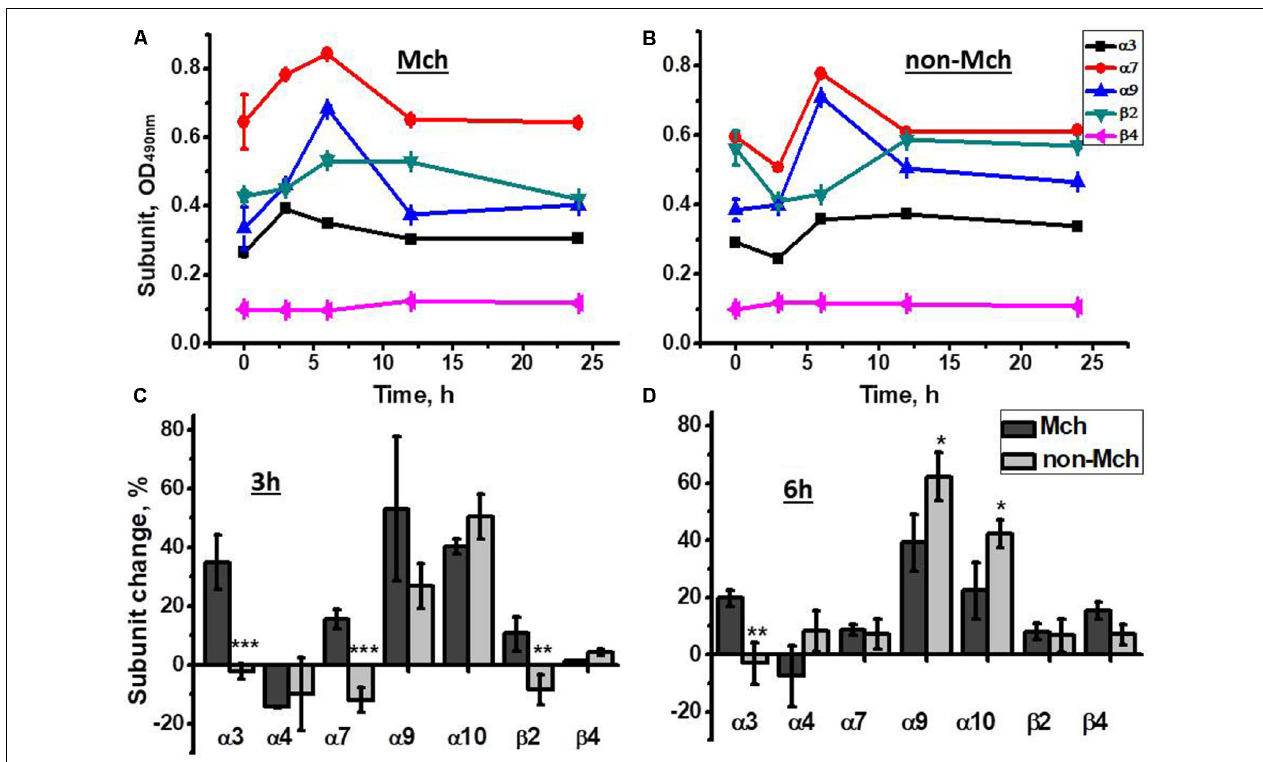
FIGURE 2 | The changes in nAChR subunits content in the mitochondria (Mch) and mitochondria-depleted (non-Mch) liver fractions of rats subjected to PHE. (A,B) Absolute OD values, one rat per each time point; (C,D) normalized values for three rats per each time point compared to the section of the liver removed during hepatectomy (mean ± SE). ∗ p < 0.05; ∗∗ p < 0.005; ∗∗∗ p < 0.0005 compared to mitochondrial